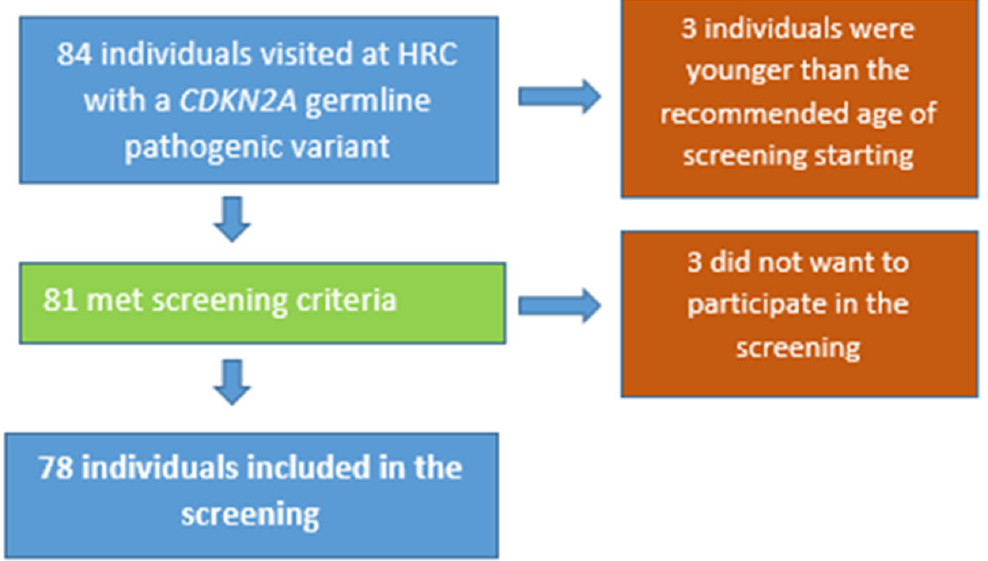
Figure 1. Flow chart—patients included in the study. HRC, high-risk clinic. Of the total cohort, 46 (59.0%) were women, with a median age at first test of 53 years, interquartile range (IQR) 47–63. Regarding environmental risk factors, the most prevalent was tobacco, with 31 (39.7%) individuals with a history of smoking (former or current smoker). A total of 17 patients (21.8%) had a family history of PDAC and 56 (71.8%) a personal history of melanoma (Table